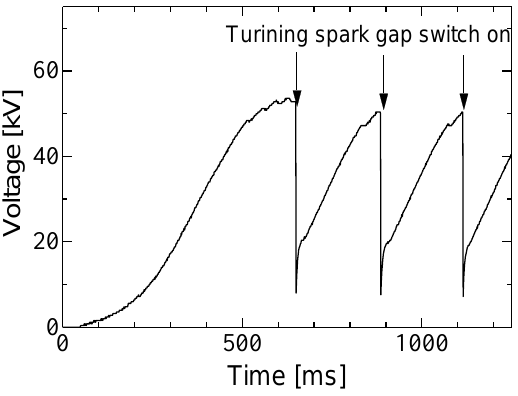
Figure 2. Waveforms of output voltage of C-W circuit during charging without load.